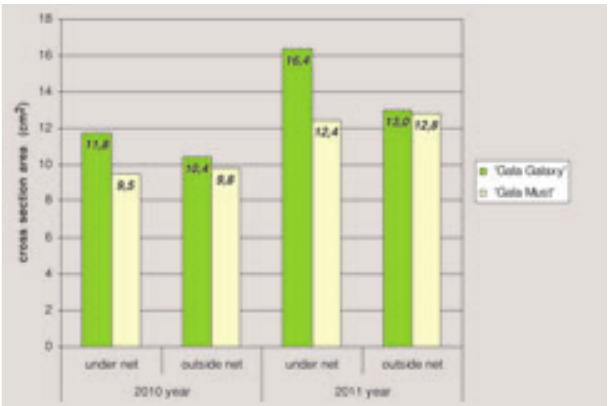
Figure 1. Changes of cross section area in the trunks of trees under and outside the hail protection nets ( Debrecen – Pallag, 2010–2011)